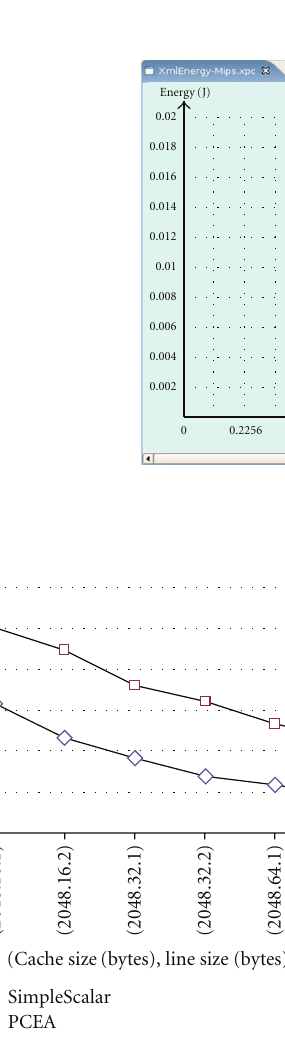
Figure 8: Normalized energy comparison for SimpleScalar and PCEA.